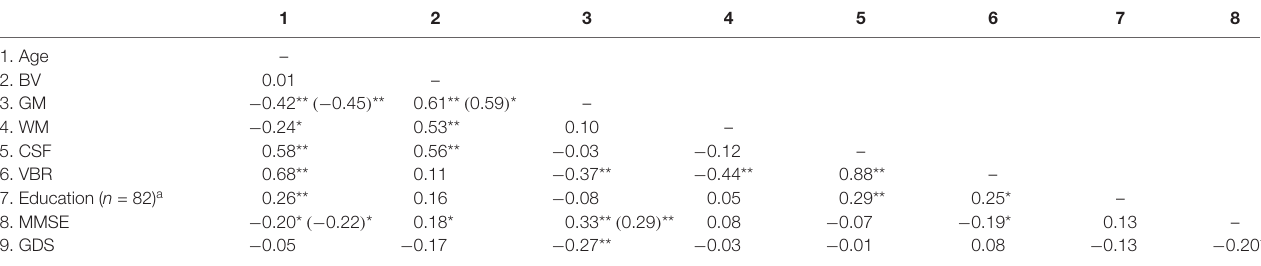
TABLE 2 | Correlations between age, MMSE, education, and volumetric indexes.